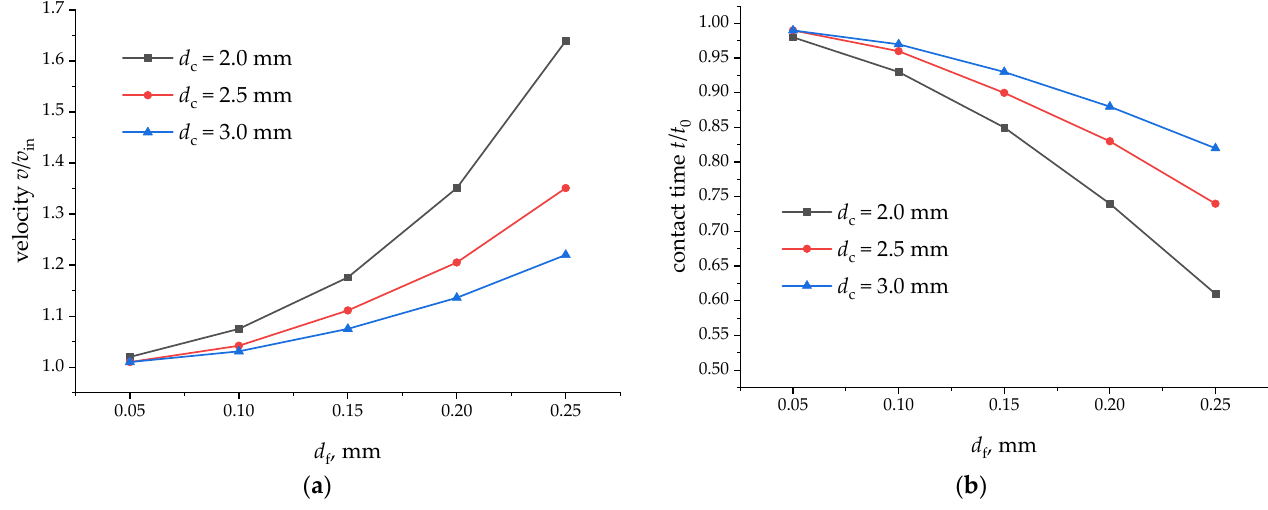
Figure 9. Gas velocity in a porous medium for different values of d c and d f : ( a ) d c = 2.0 mm. ( b ) d c = 2.5 mm. ( c ) d c = 3.0 mm.